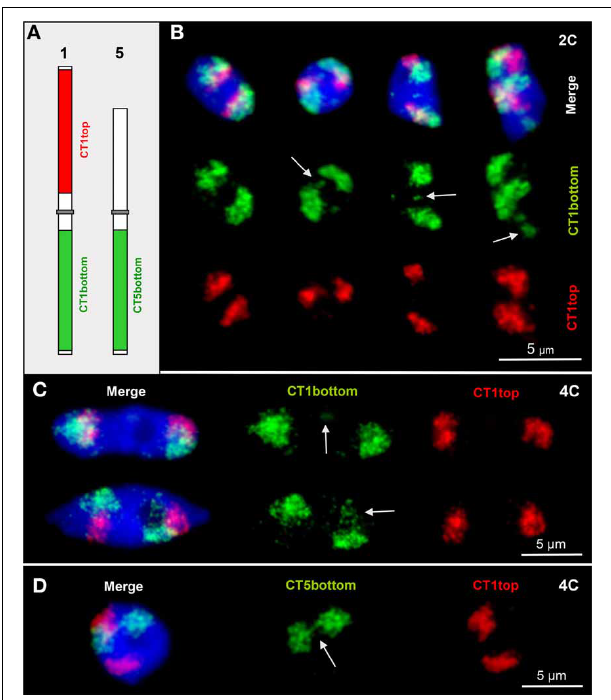
FIGURE 1 | CTs are mainly compact but allow relaxation, chromatin fiber out looping and association. (A) Scheme of chromosomes 1 and 5 showing the labeling of the euchromatic CT1top, CT1bottom and CT5bottom arm segments by FISH. (B) Arrows mark chromatin domains clearly located outside of their CTs in 2C nuclei. The left nucleus contains compact CTs of both homologs without external chromatin. (C) Minor (top arrow) and larger (bottom arrow) chromatin segments separated from CT1bottom arms in 4C nuclei. (D) Due to chromatin fiber out looping in this 4C nucleus, the homologous CT5bottom arms are connected